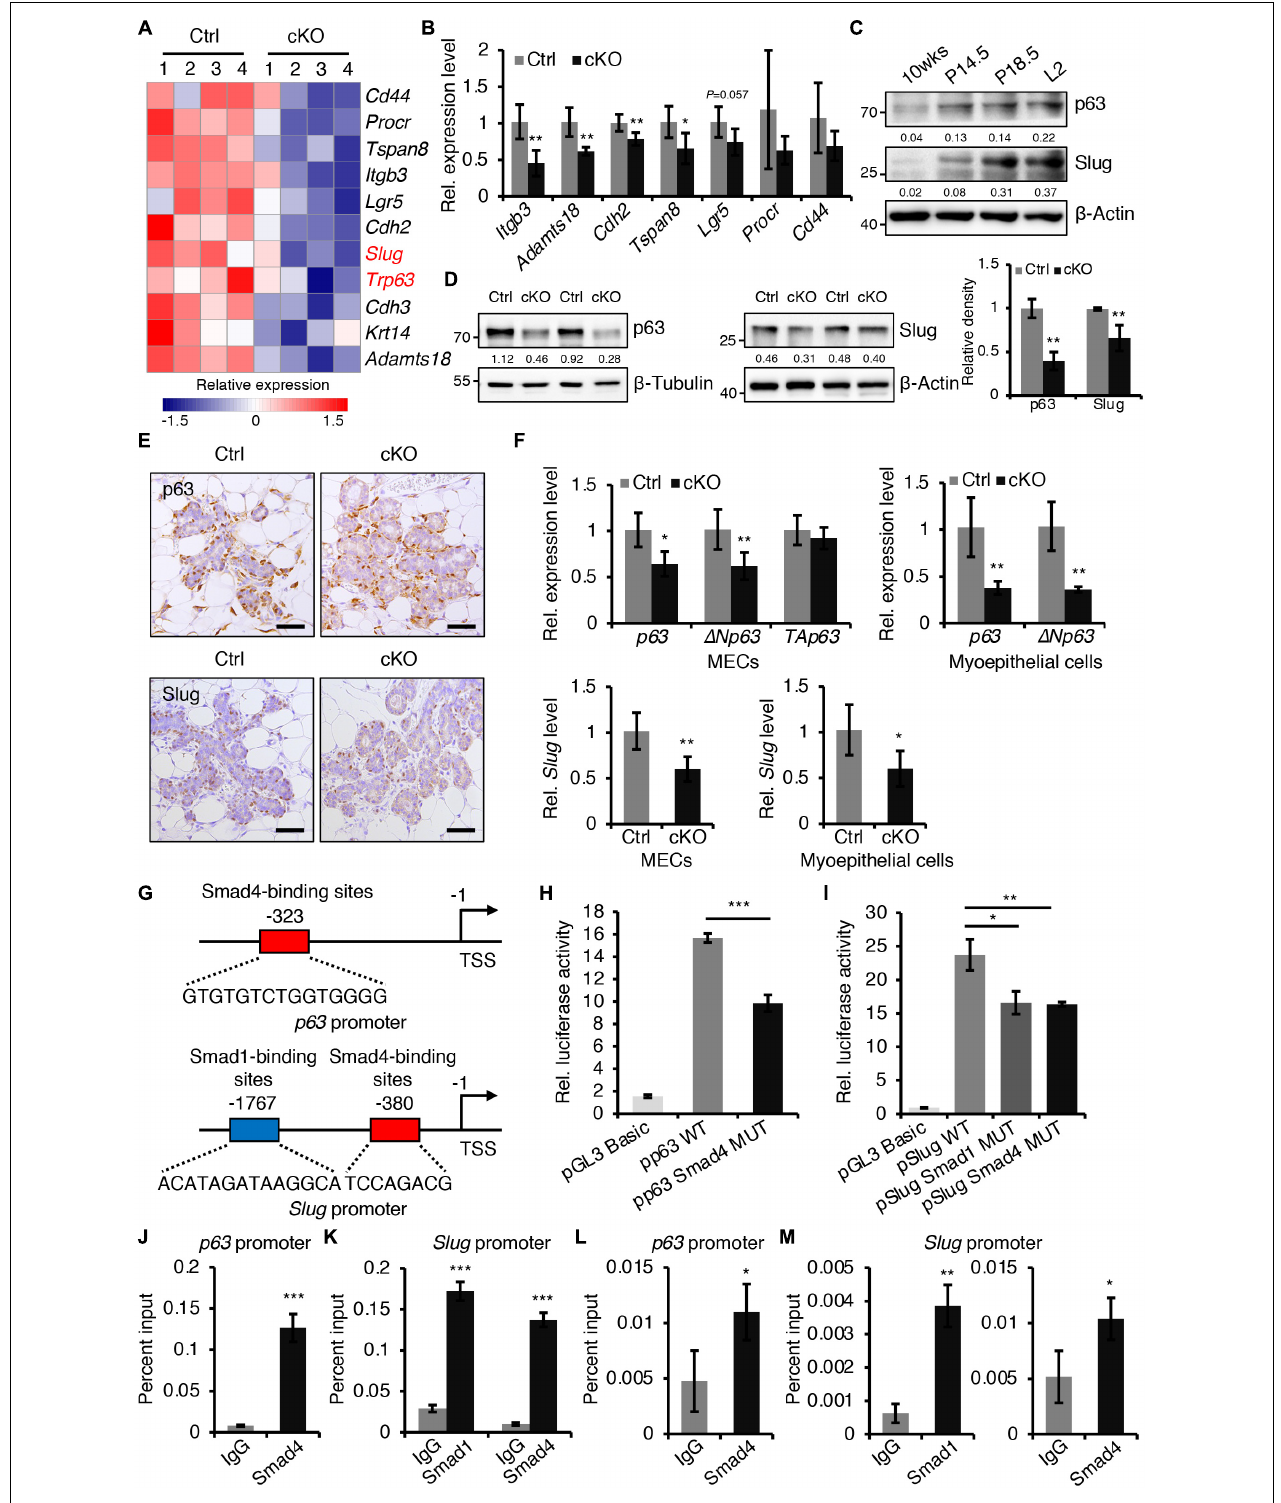
FIGURE 5 | BMPR1a regulated the expression of p63 and Slug through the pSmad1/5-Smad4 complex. (A) Heatmap for myoepithelial layer-related gene expression in control and cKO mammary glands at pregnancy day 14.5. n = 4 mice per group. (B) qRT-PCR analysis of Itgb3, Adamts18, Cdh2, Tspan8, Lgr5, Procr, and Cd44 in FACS-sorted myoepithelial cells from control and cKO mice at pregnancy day 14.5. n = 4–5 biological replicates. (C) Western blotting for p63 and Slug in wild-type mouse mammary glands at the indicated time points (P14.5, pregnancy day 14.5; P18.5, pregnancy day 18.5; L2, lactation day 2). β -Actin was used as a